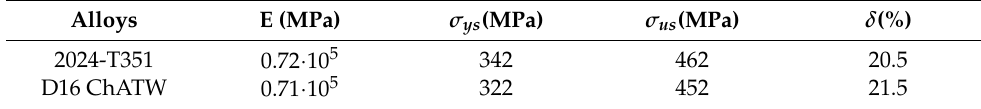
Table 1. Mechanical properties of the aluminum alloys studied.